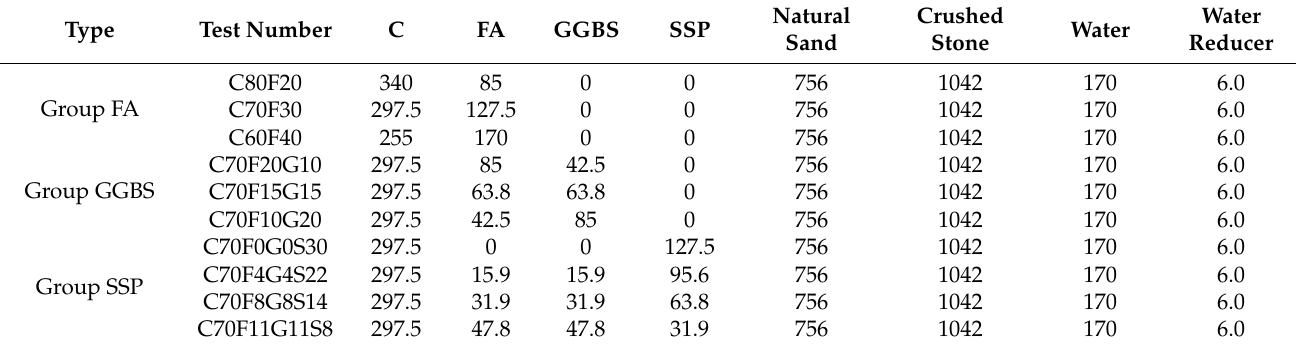
Table 6. Design of concrete mix per cubic meter (kg).